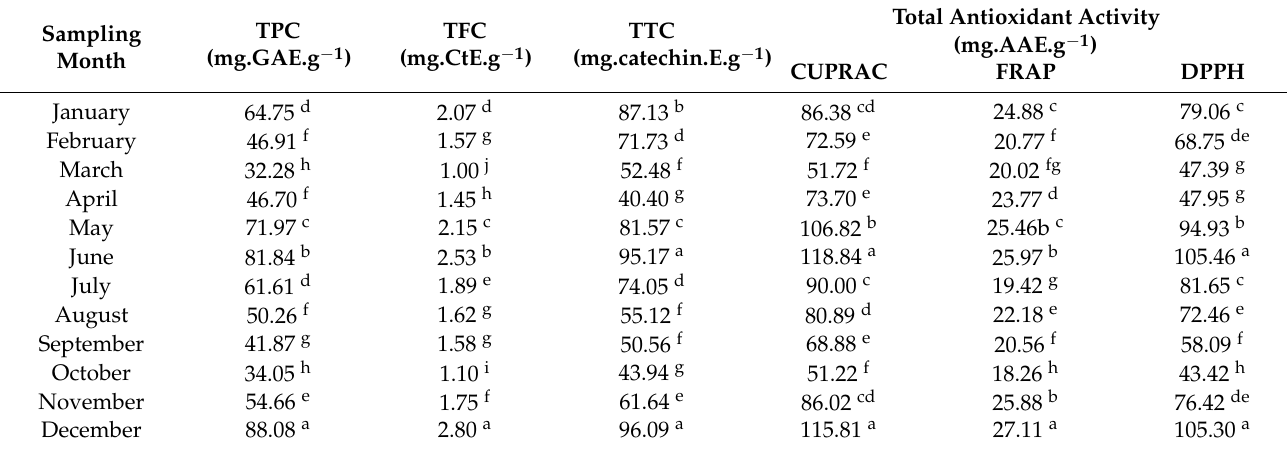
Table 1. Seasonal variation in TPC, TFC, TTC and total antioxidant activity in CUPRAC, FRAP, and DPPH assay of C. polygonoides foliage. Different letters indicate the significant difference between harvesting times for the same category according to Duncan’s test ( p < 0.05). Values are mean of three replications.